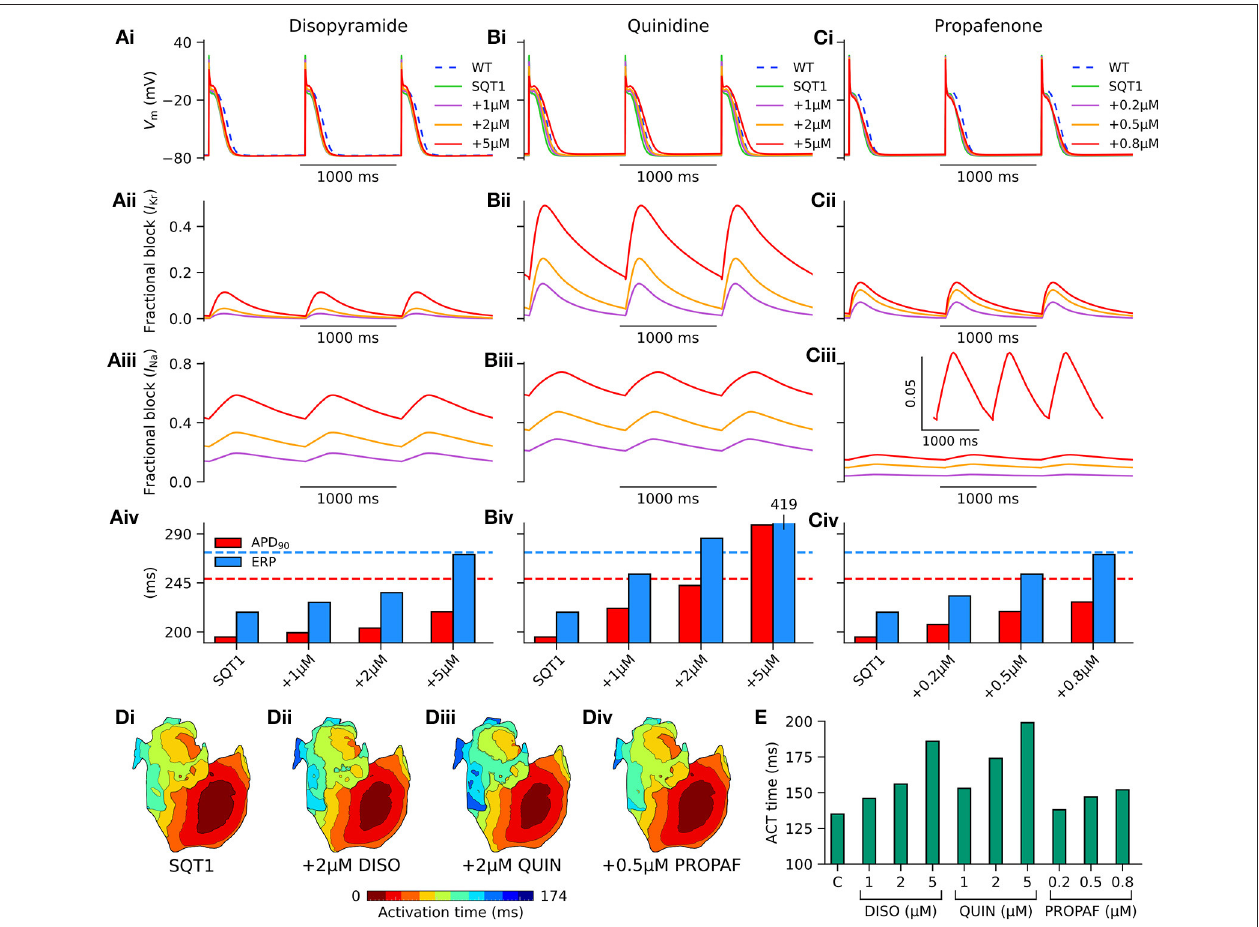
FIGURE 5 | Effects of class I drugs on human atrial electrophysiology in SQT1. Effects of (A) disopyramide (DISO), (B) quinidine (QUIN), and (C) propafenone (PROPAF) on (i) single human atrial cell action potentials (APs) under wild type (WT) conditions (blue, dashed line), drug-free WT-N588K (SQT1) conditions (green, solid line), and SQT1 + varying drug concentrations (purple, orange, and red solid lines). Corresponding fractional block of (ii) I Kr and (iii) I Na , and (iv) increase in APD 90 (red) and effective refractory period (ERP; blue). (D) Activation sequences in the 3D anatomical human atria model under (i) drug-free SQT1 (control – C), (ii) SQT1 + 2 µ M DISO, (iii) SQT1 + 2 µ M QUIN, and (iv) SQT1 + 0.5 µ M PROPAF conditions, with corresponding (E) activation (ACT) time summarized as a barchart. All simulations performed at a basic cycle length of 1,000ms.